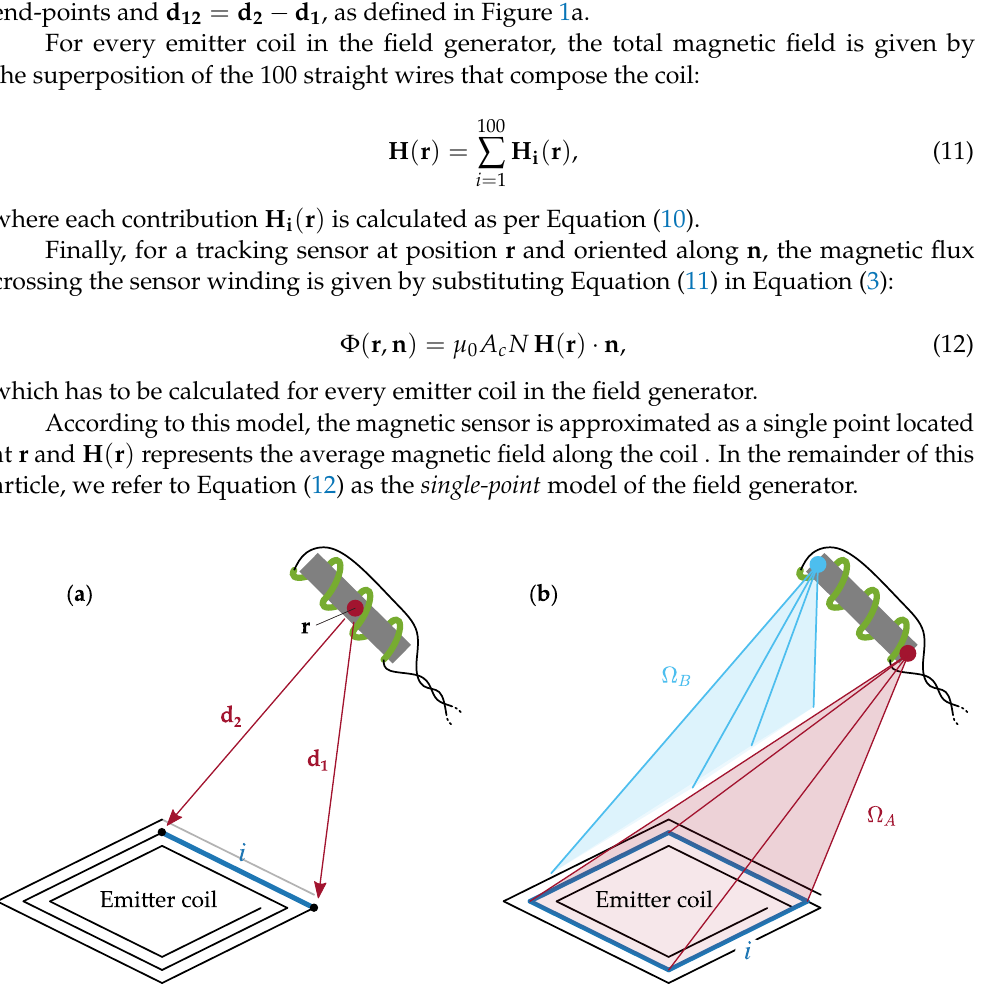
Figure 1. Calculation of the magnetic flux crossing an elongated inductive sensor: ( a ) from the sum of the contributions due to the individual filaments forming the emitter coil, where the sensor is approximated as a single point; ( b ) the full sensor length is considered by calculating the flux as the finite difference of the magnetic scalar potential, which depends on the solid angles, Ω A and Ω B , subtended by the emitter coil current path at the sensor